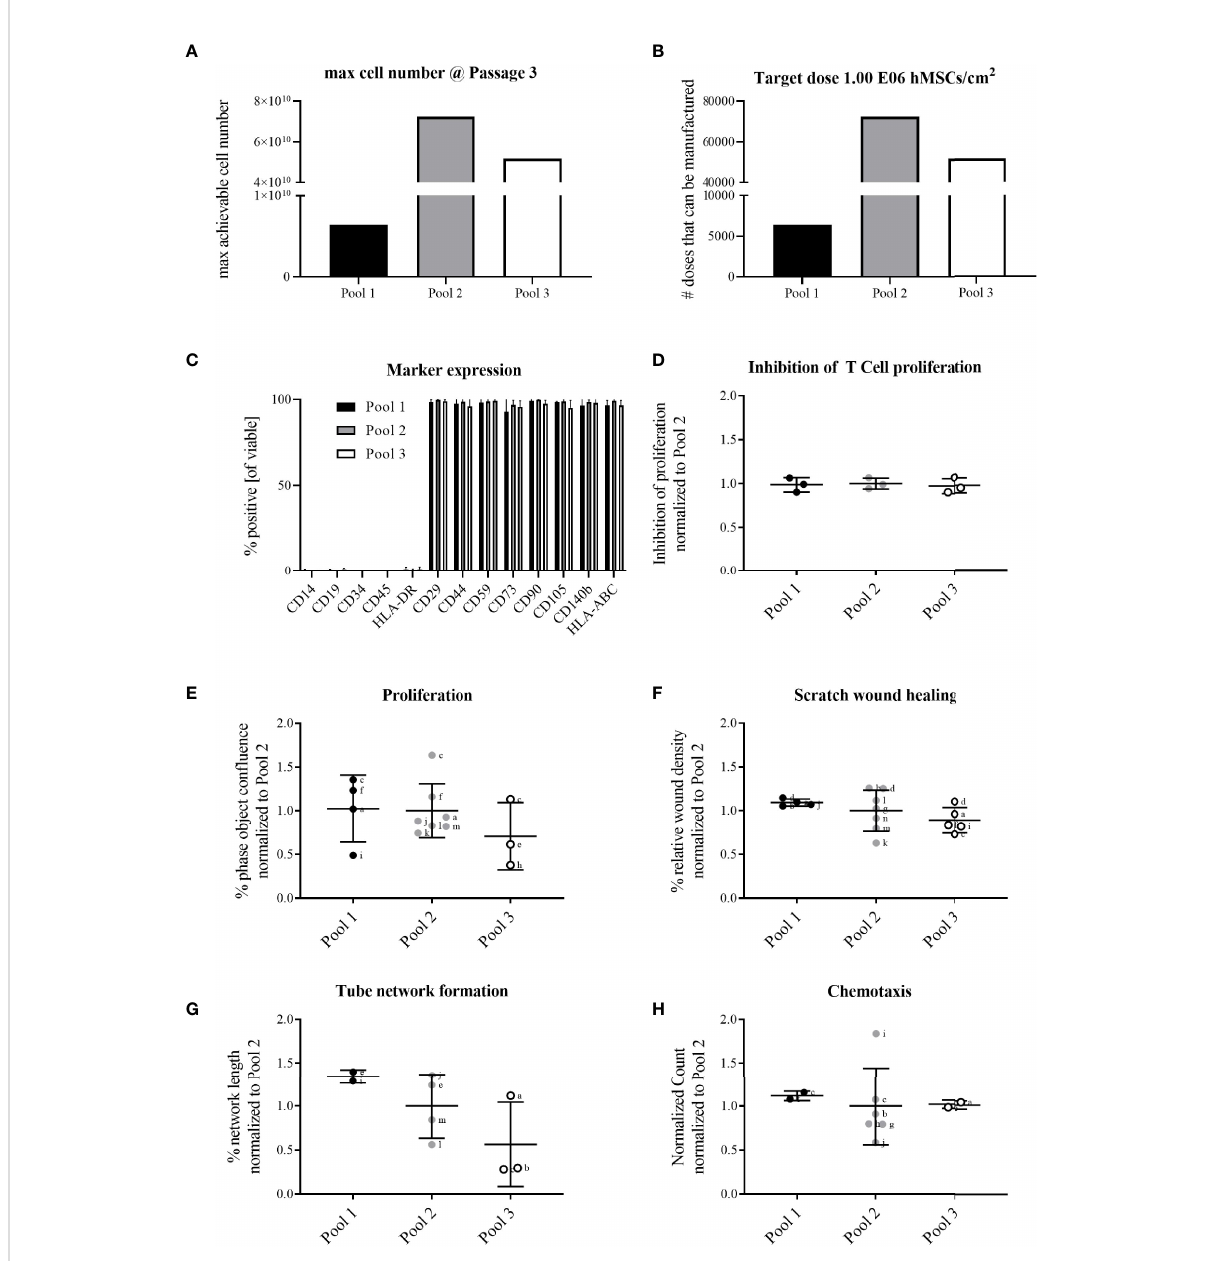
FIGURE 3 All hMSC pools featured similar proliferation capacity, yet with Pool 2 hMSCs the highest number of extrapolated clinical doses could be achieved. All pools exerted similar functional characteristics. Calculation of (A) maximally achievable cell doses/manufacturing batch and (B) cell doses manufactured/batch (1x10 6 hMSCs/cm 2 wound size) for hMSCs pooled at either passage 1 (Pool 1), passage 2 (Pool 2) or passage 3 (Pool 3). (C) Flow cytometry characterization of binary (absent or present) hMSCs markers. (D-H) Functional characterization of hMSC pools. Data are shown as normalized to the average of Pool 2. (D) hMSCs-mediated inhibition of PHA-driven T cell proliferation. (E – H) Live cell imaging analyses of functional hMSC attributes: (E) proliferation; phase object con fl uence 96h post-seeding; (F) scratch wound healing: relative wound density at 24h post-wounding; (G) tube network formation: hMSCs were seeded as monolayer and fl uorescently-labeled endothelial cells (HUVEC) were seeded on top. Tube length was assessed 48h post-seeding and calculated as percent of human adipose stromal cell-mediated tube formation; (H) chemotactic migration to hPL-supplemented medium in bottom chamber. Counts of migrated cells in bottom wells were normalized to initial top-well values. Serum-free medium served as negative control. (E – H) Small letters indicate experimental replicates performed on different days by different operators. All data are shown as data from individual experimental replicates, indicating mean ±